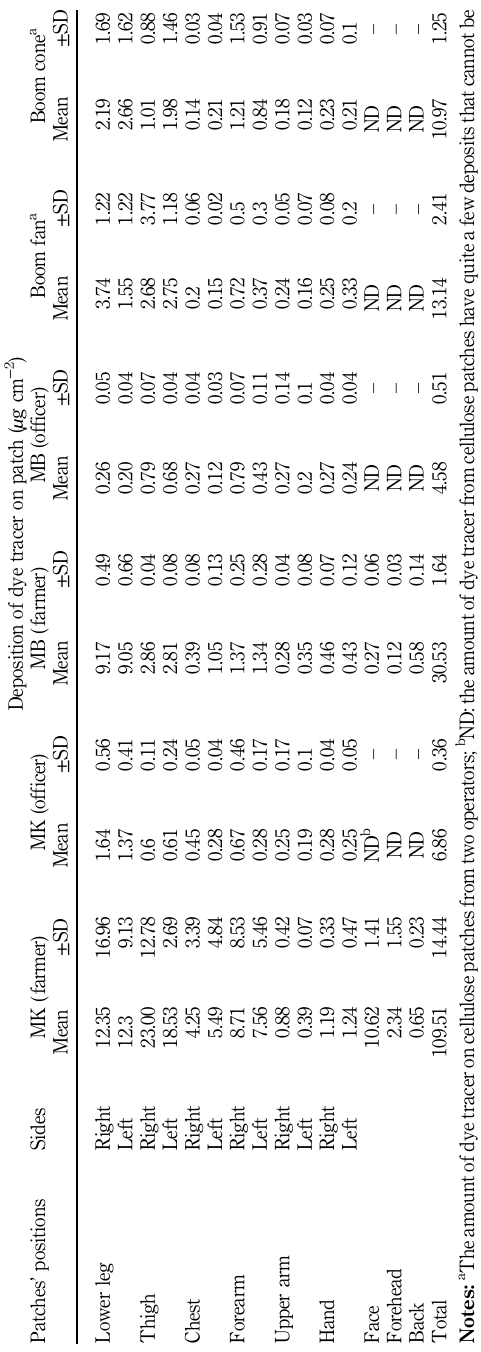
Table II. The deposition of dye tracer detected from cellulose patches: mean and standard derivations expressed as µ g cm − 2 on different spray application techniques (on rice at the tillering